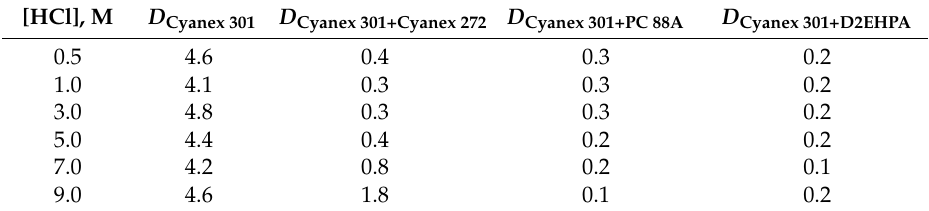
Table 2. Distribution ratio of Pd(II) with single Cyanex 301, Cyanex 301 + Cyanex 272, Cyanex 301 + PC 88A, and Cyanex 301 + D2EHPA.